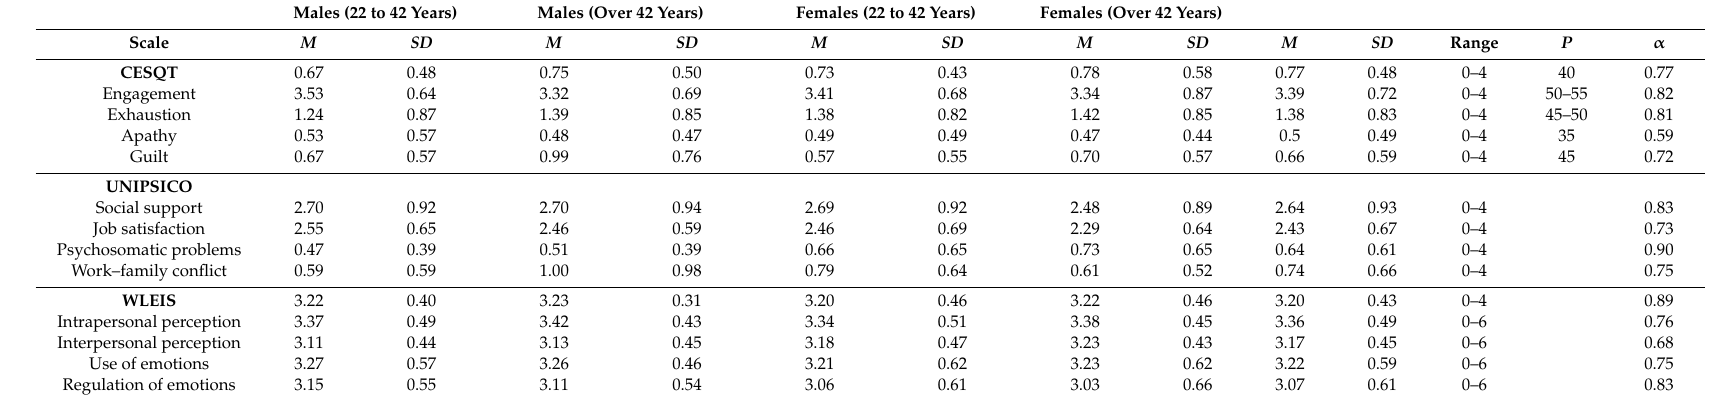
Table 1. Shows the descriptive analysis of the studied variables. Means, standard deviations, and centiles of the